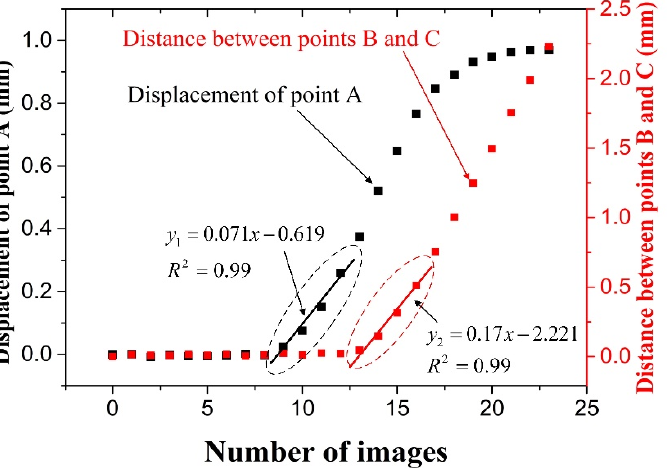
Figure 7. Scatter diagram of displacement change at point A and distance variation between points B and C of the specimen with a turning point in the load–time curve.